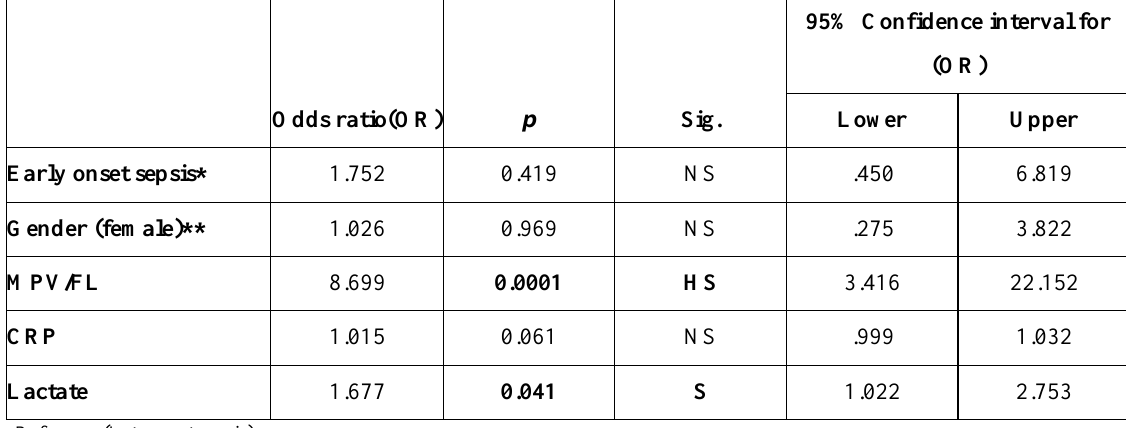
Table 5. Logistic regression for studying independent factors associated with Gram-positive culture cases.